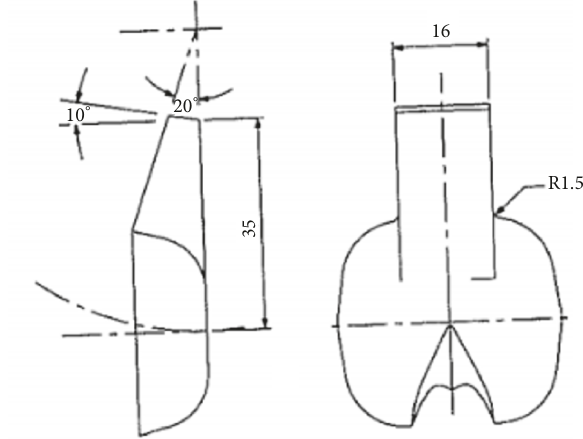
Figure 5: A basic bucket stem design for bolted fixing. All dimen- sions are in % PCD